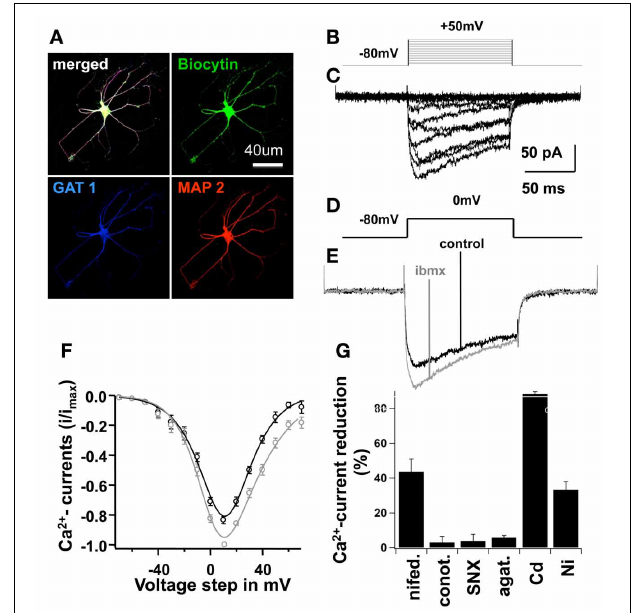
FIGURE 5 | High cAMP increased L-type Ca 2 + -currents in mature cells. In (A) , an example of a mature cell is shown; this cell was filled with Biocytin during recording and further stained for MAP2 (a mature neuronal marker), and Gat-1 (GABA amino-transporter) after fixation. In ( B ), stimulation protocol in voltage-clamp, pulse duration 100ms, holding potential − 80mV, stimuli from − 70 to 50mV at 10mV increments. In (C) , voltage-clamp traces, average of 5 consecutive sweeps with subtraction of leak and capacitive currents (see text), showing Ca 2 + -influx currents. In (D) , voltage pulse of 0mV to obtain traces shown in (E) . In (E) , Ca 2 + -influx was recorded in a control situation using the standard bath saline solution, and with 0.5mM IBMX alone. Traces represent average of 10 consecutive sweeps, for at least 5min; series resistance remained constant throughout the experiment. In (F) , current-voltage (I–V) relationship of Ca 2 + -influx under each condition mentioned above, bars represent SEM, data were fitted with a modified Goldman-Hodgkin-Katz equation of the form I ( V ) = PV ([ D − exp( − V / C )]/[1 − exp( V/C )]) ∗ [1/(1 + exp[( V 1 / 2 − V )/ V slope ])], see text. In (G) , Ca 2 + -current peaks at 0mV were recorded with different specific Ca 2 + -blockers of L, T, P/Q and N-type Ca 2 + -channels to dissect the current-subtypes present in NSCs at this maturation phase. Bars represent percentage of current reduction in the control situation and after blocker